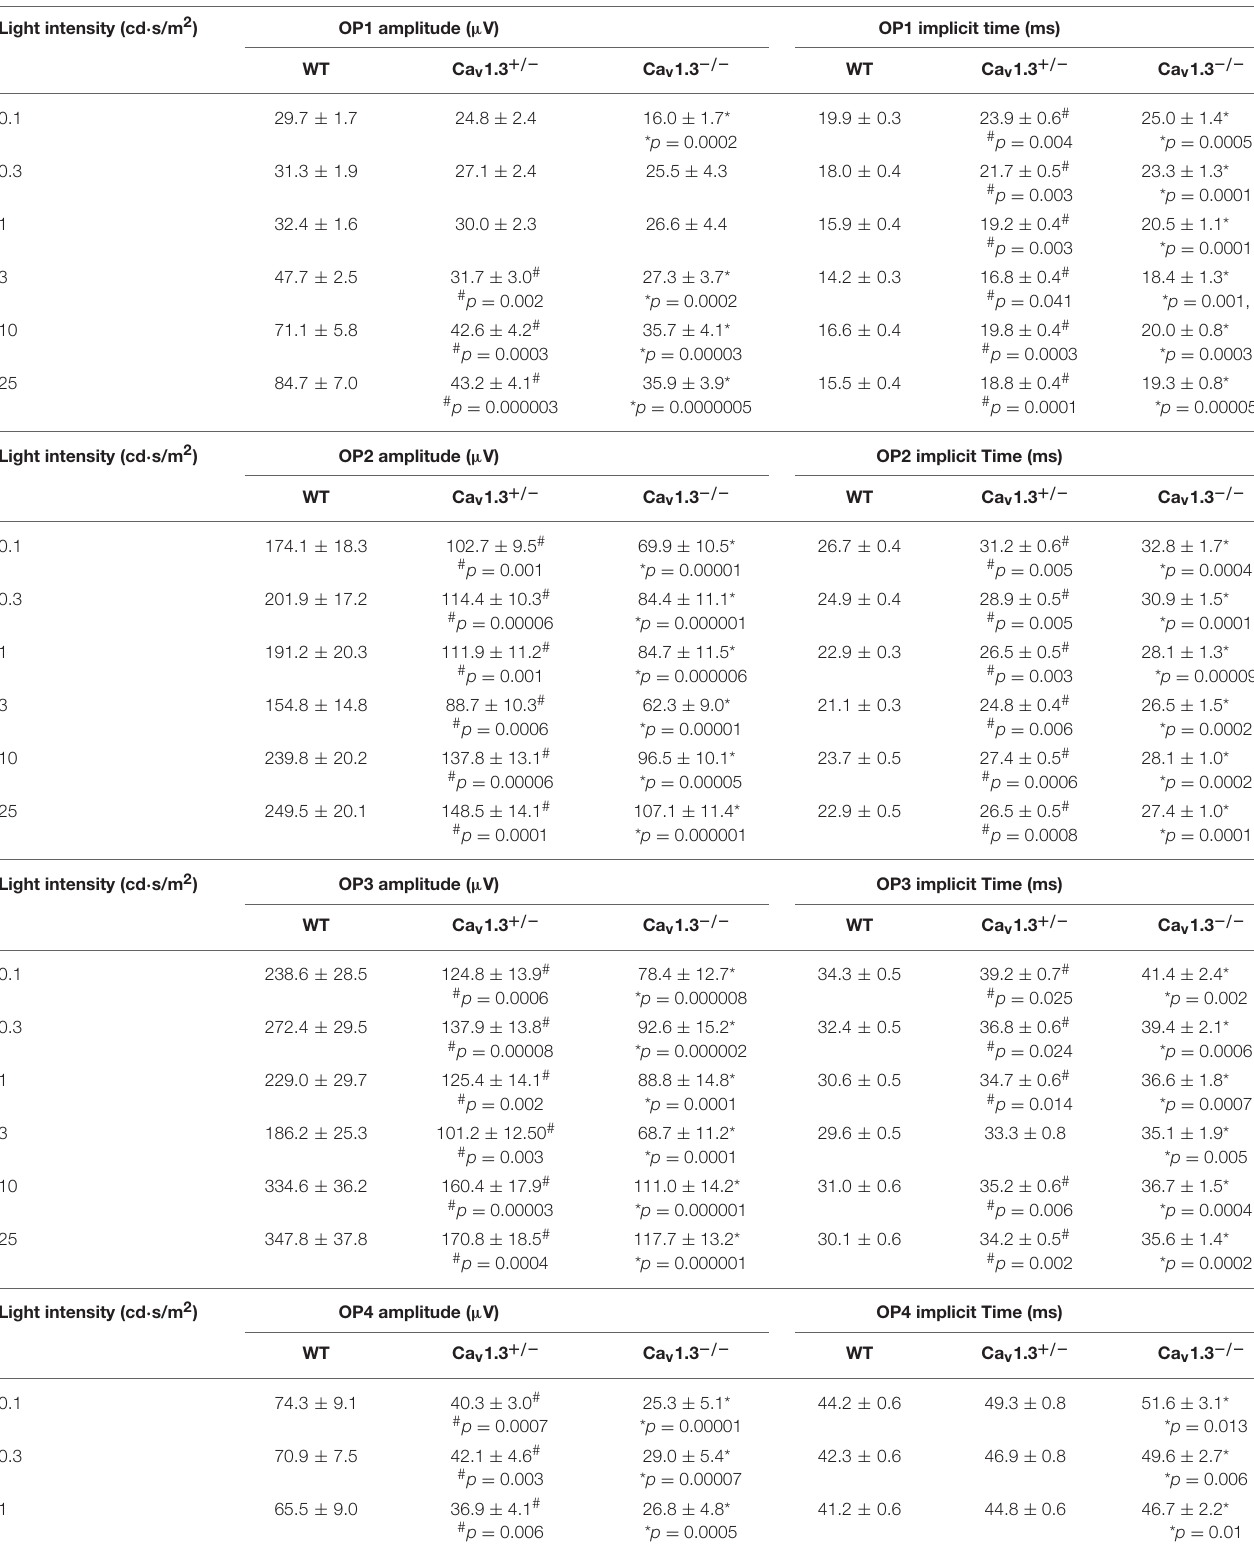
TABLE 2 | Oscillatory Potential Responses (Data for Figures 5A–H